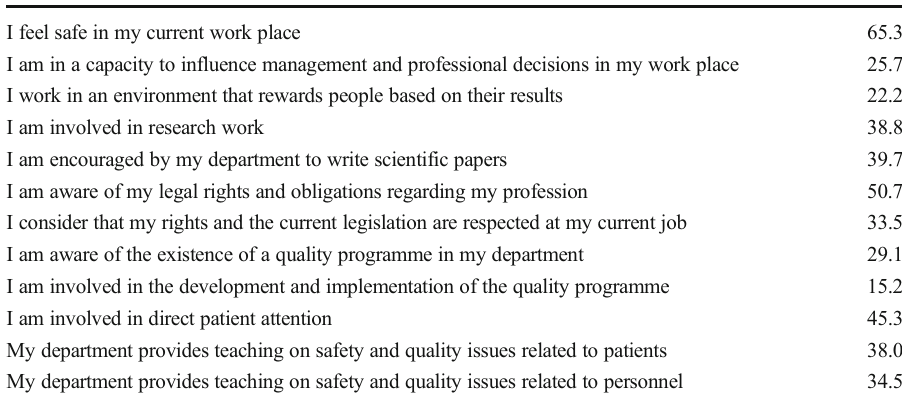
Table 1 What do you think about your working